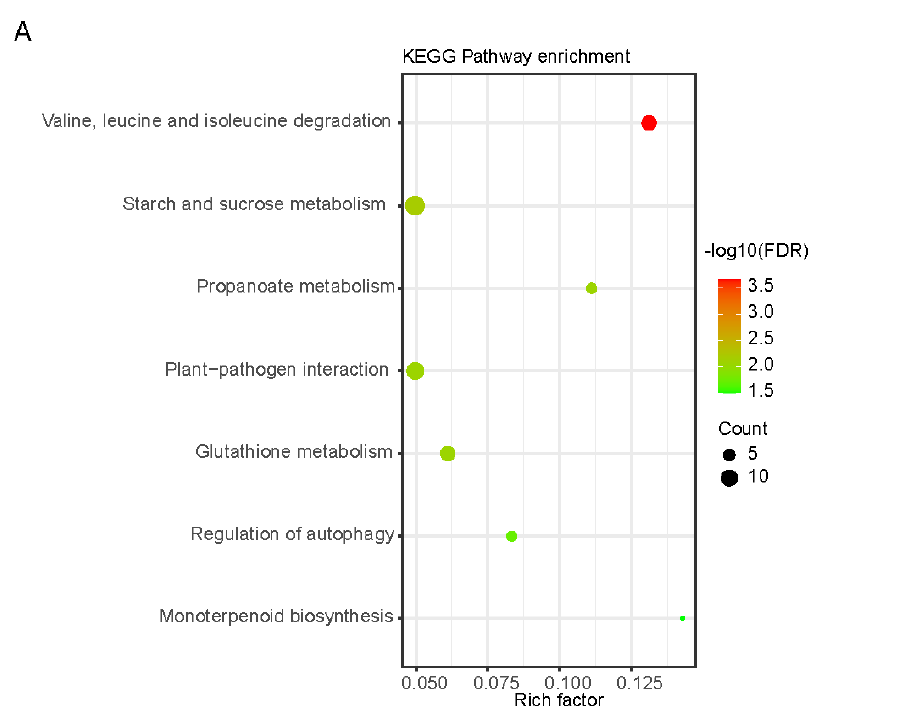
Figure 7. KEGG enrichment of MEyellow module genes ( A ) and heatmap of each sample expression level of starch and sucrose metabolism genes ( B ).